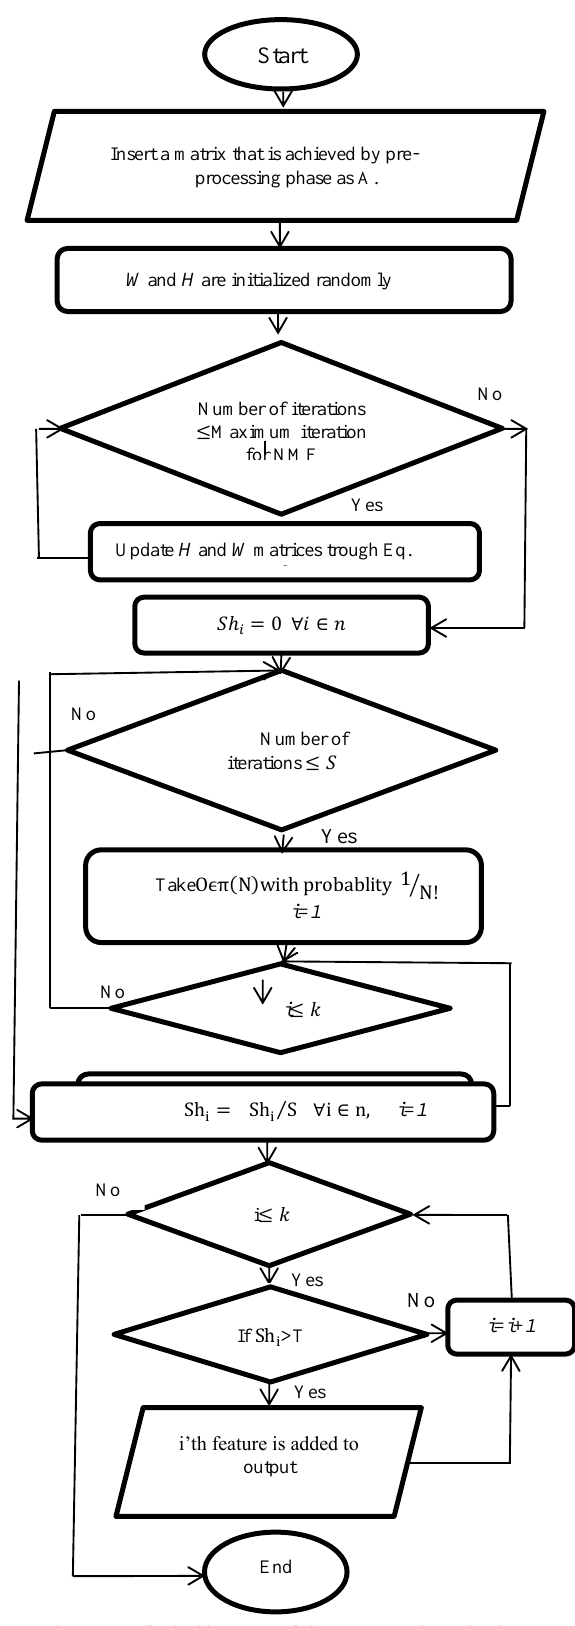
Figure 1. Block diagram of the proposed